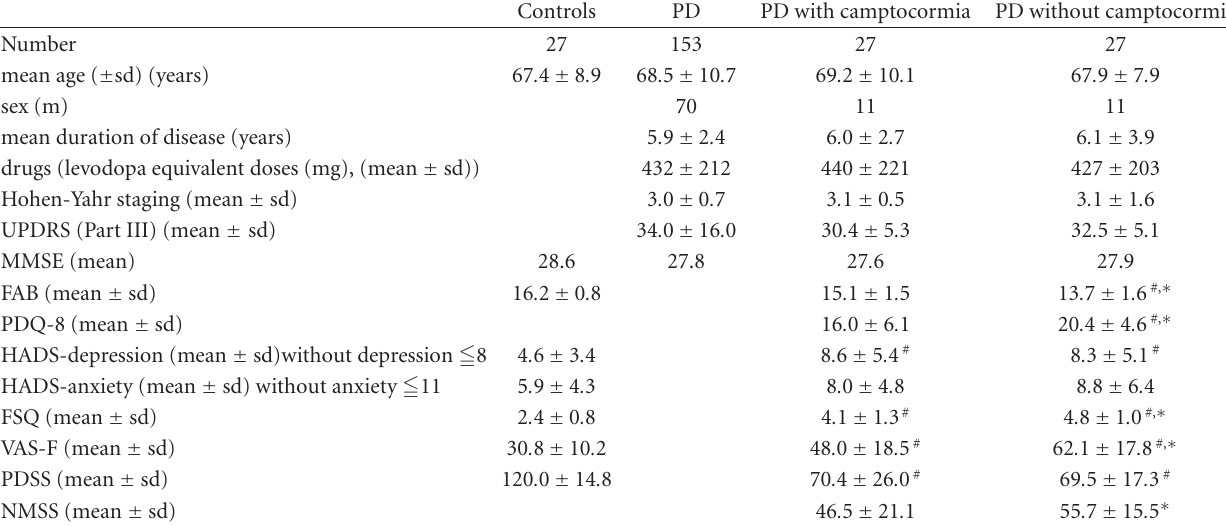
Table 1: Demographic and clinical details of Parkinson’s disease patients with and without camptocormia, and controls.